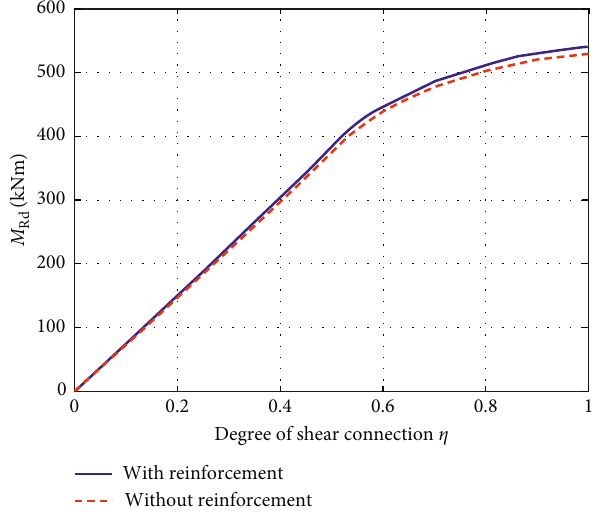
Figure 17: Resisting bending moment-degree of shear connection relation with and without taking into account reinforcement in the concrete slab, Section 3 C35/45